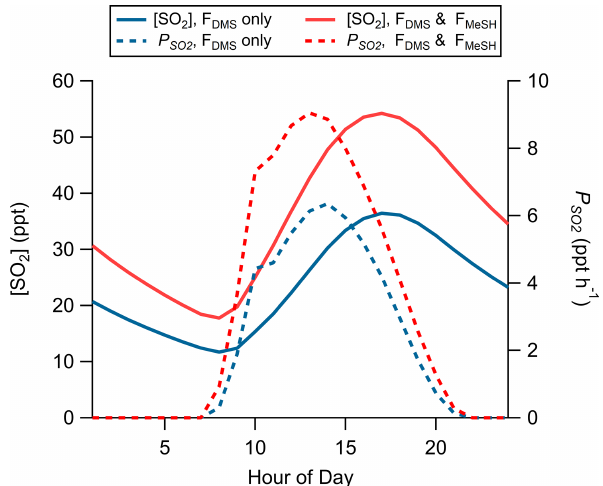
Figure 8. Modeled diel profiles of SO 2 mixing ratios and instan- taneous SO 2 production rates ( P SO ) for a model case considering 2 only DMS emissions ( F DMS only, blue traces) and one including both DMS and MeSH emissions ( F DMS and F MeSH , red traces). Emissions were taken as the measured campaign mean flux of DMS and MeSH.